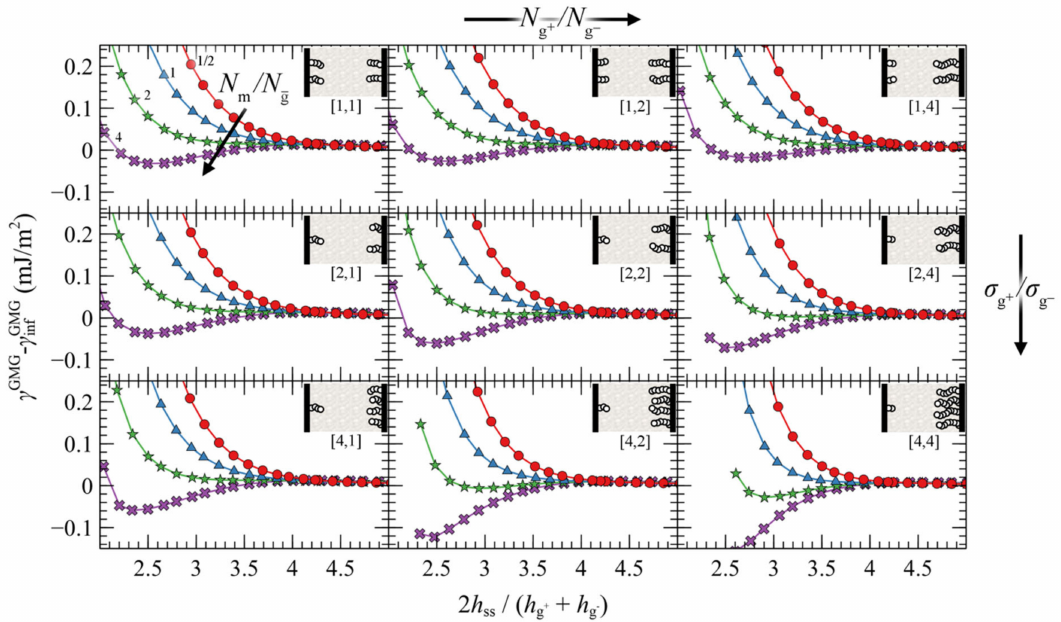
Figure 11. Potential of mean force against the reduced surface-surface distance for approaching grafted silica surfaces. Colors correspond to evaluations for N m / N g = 1/2 (red), 1 (blue), 2 (green) and 4 (purple), whereas the small legends in brackets below the insets denote the ratios σ g + / σ g − and N g + / N g − , respectively. The top left panel corresponds to the reference symmetric case with σ ref g = σ g − = σ g + = 0.2 nm –2 and N ref g = N g − = N g + = 96. The actual N g ± and σ g ± for each case can be retrieved as follows: N g ± = N ref g n ± 1/2 and σ g ± = σ ref g m ± 1/2 , with [ n , m ] = [ N g + / N g + , σ g + / σ g − ] being the numbers at the legends under the insets. It should be noted that inset schematics belonging to panels other than the corner √ ones are only approximate; in these cases, σ g + / − and N g + / − are scaled by a factor of ±